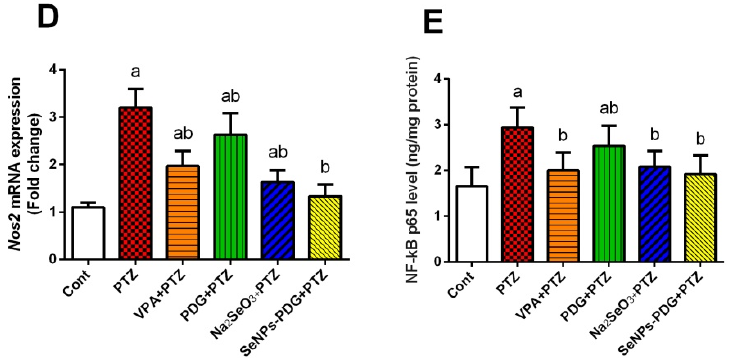
Figure 3. Effects of orally administered prodigiosin (PDG), sodium selenite (Na 2 SeO 3 ), and green biosynthesized SeNPs with PDG (SeNPs-PDG) on the levels of inflammatory mediators, including ( A) TNF- α , ( B ) IL-1 β , ( C ) Cox-2, ( D ) Nos2 mRNA expression, and ( E ) NF- κ B in hippocampal tissue